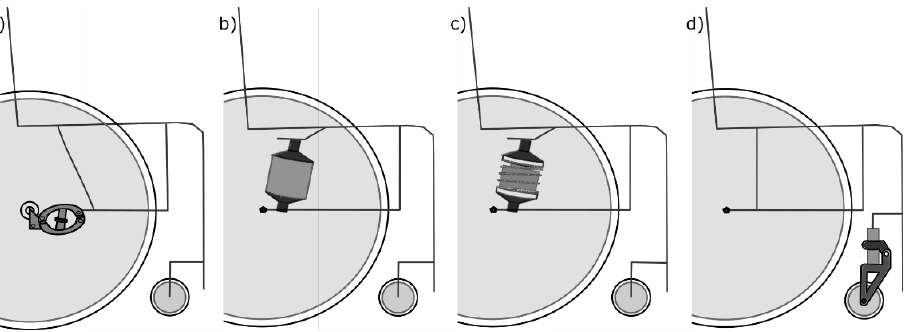
Figure 2. Representation of polymer-based shock ( a , b ), and spring damper ( c ) rear-wheel suspension, and a type of caster fork suspension ( d ).